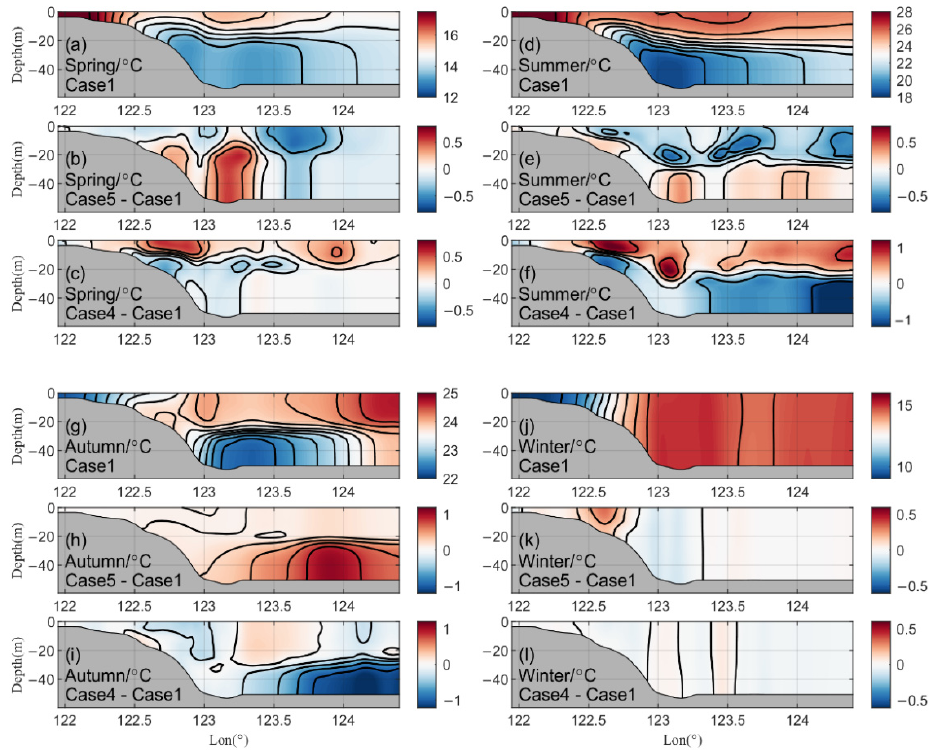
Figure 9. The sectional distribution of sea temperature (°C, 31° N). ( a , d , g , j ) (case 1 results in Spring, Summer, Autumn and Winter); ( b , e , h , k ) (the difference between case 1 and case 5 in Spring, Summer, Autumn and Winter); ( c , f , i , l ) (the difference between case 1 and case 4 in Spring, Summer, Autumn and Winter).